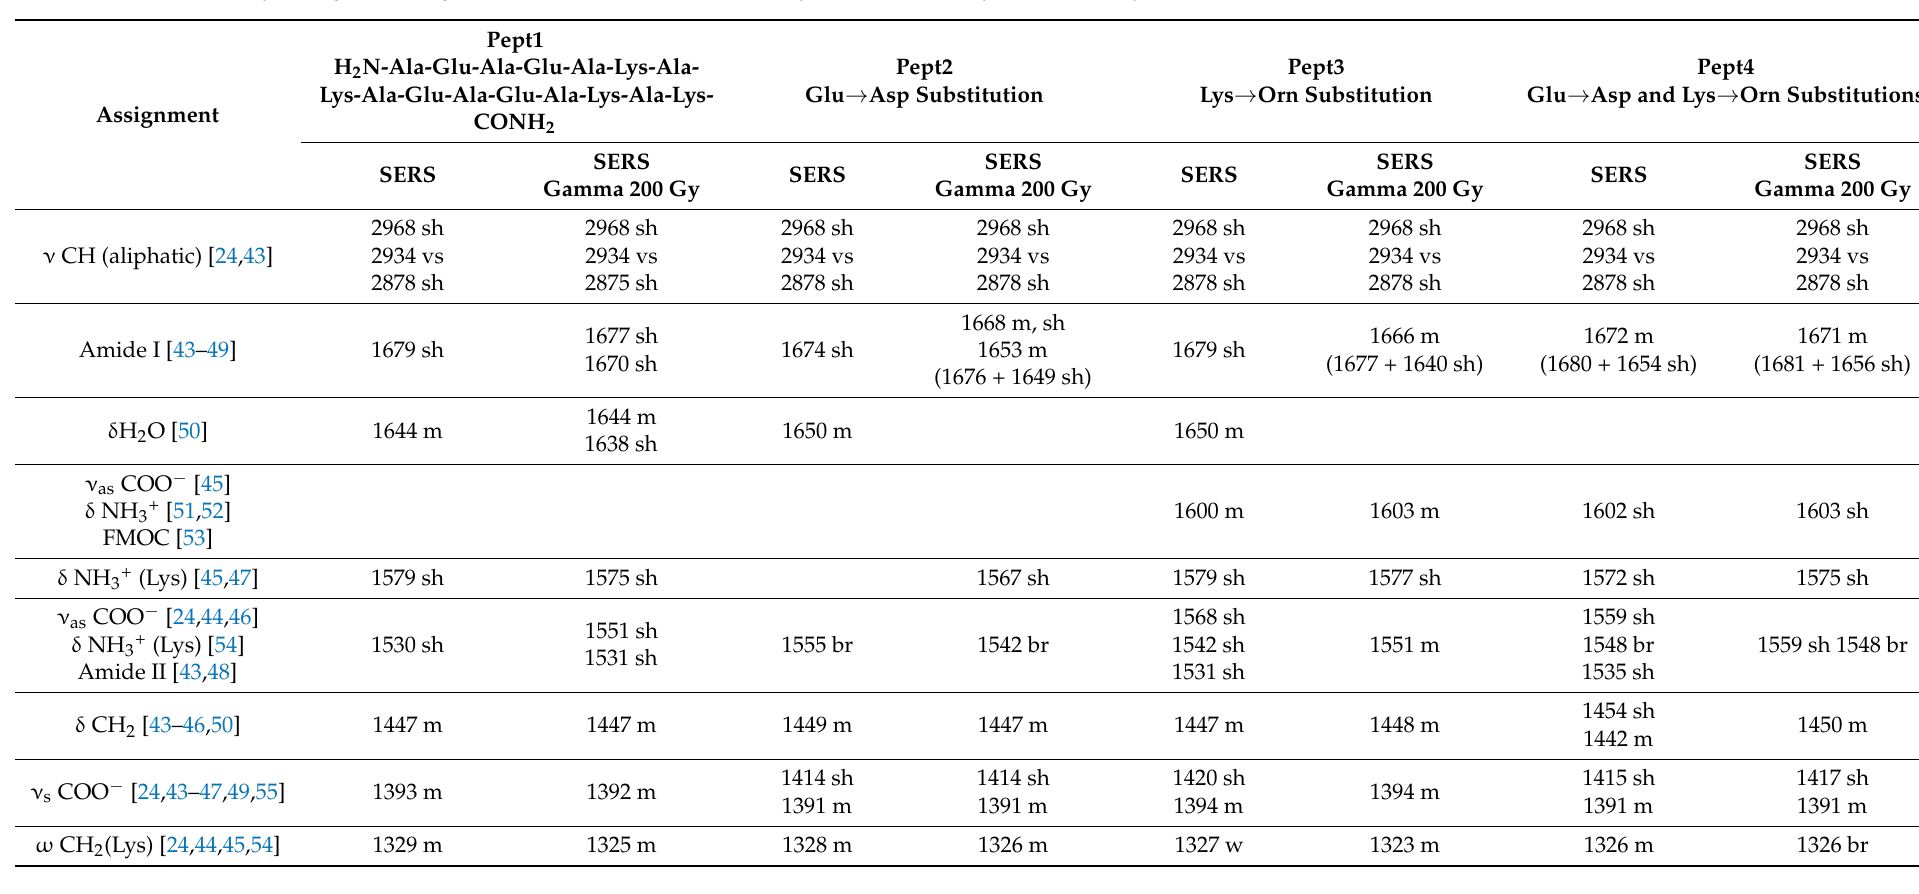
Table 1. Attribution of experimental SERS (Surface-Enhanced Raman Scattering) spectra of Pept1, 2, 3, and 4. In the “Assignment” column, the attributions obtained by the PED analysis on the most stable peptide–Ag 2 geometry is reported (except for Pept4, whose attributions are not supported by PED analysis and are made in agreement with those of the other peptides). These attributions were further confirmed by those present in the literature. (Interpretation of vibrations: ν = stretching, δ = bending, τ = torsion, ω = wagging, ρ = rocking, sh = shoulder, br = broad, vs = very strong, s = strong, m = medium, w = weak, vw = very weak, as = anti-symmetric, s = symmetric).